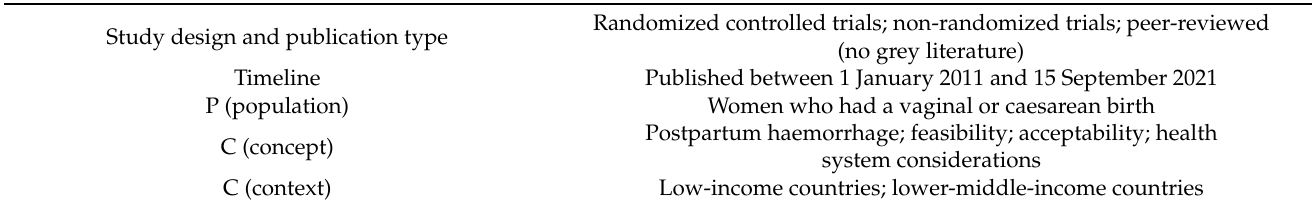
Table 1. Eligibility